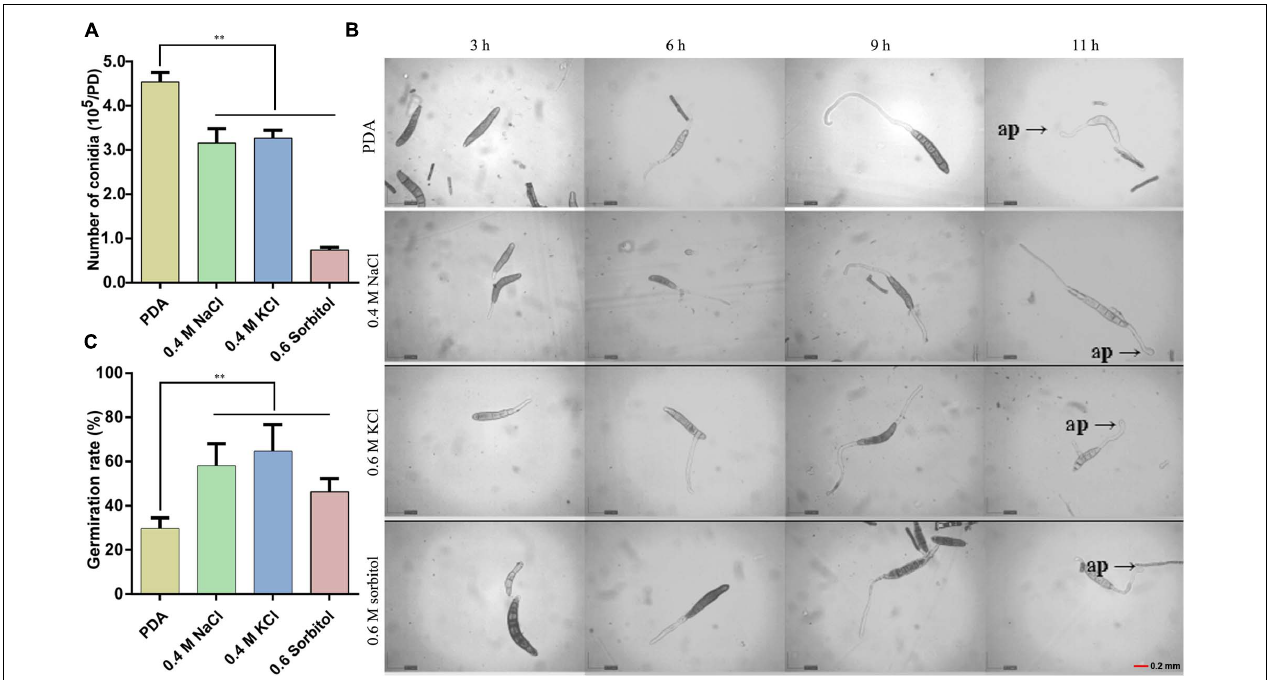
FIGURE 4 | Observation of conidia germination after 20 days of culture under the three osmotic conditions (0.4 M NaCl, 0.4 M KCl, and 0.6 M sorbitol) and control (PDA). (A) The number of conidia produced by the hyphae under the four media. (B) The conidial suspension was incubated on cellophane at 25 ◦ C in the dark and observed at 3, 6, 9, and 11 h after inoculation under a microscope and (C) the quantitative statistics from three independent petri dishes. ap: appressorium, Data are presented as the mean ± SD of three independent experiments.** P <